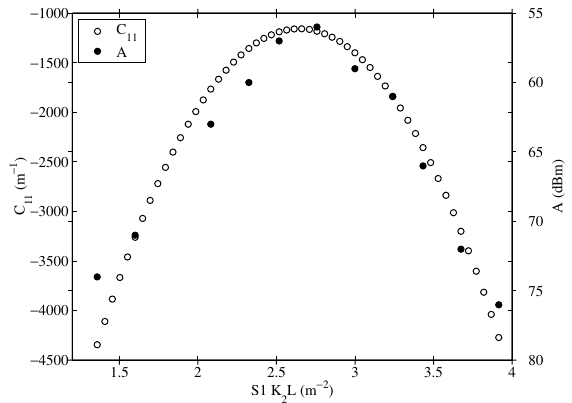
FIG. 4. Comparison of the amplitude of HCBM 318 with C as functions of the harmonic sextupole strength.